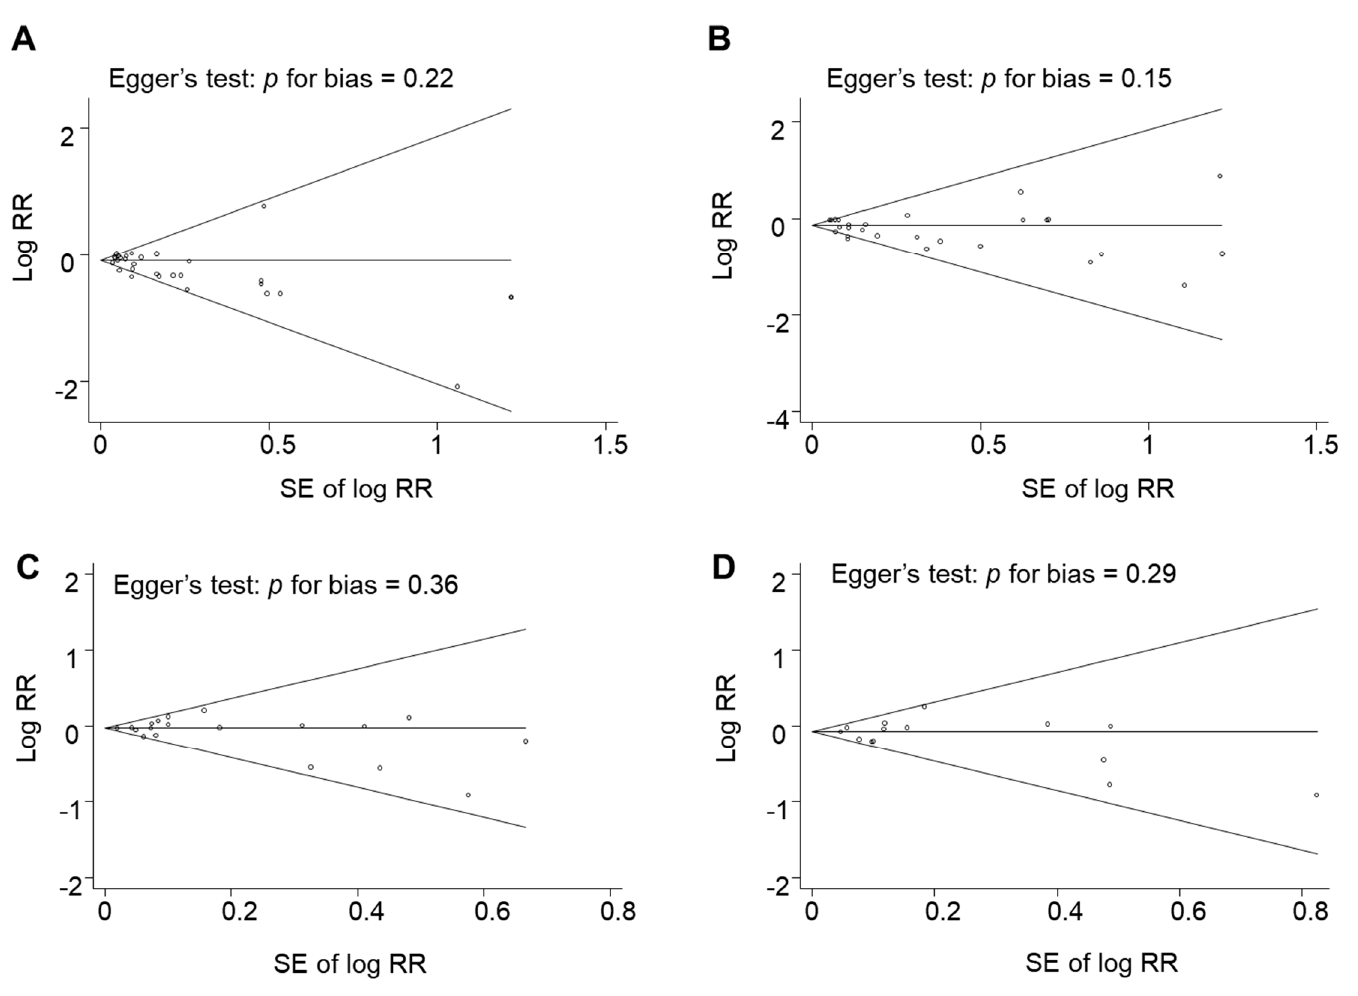
Figure A9. Funnel plot analysis to detect publication bias: ( A ) statins and all-cause mortality; ( B ) statins and cardiovascular disease death; ( C ) omega-3 supplementation and all-cause mortality; and ( D ) omega-3 supplementation and cardiovascular disease death). RR, relative risk; SE, standard error.